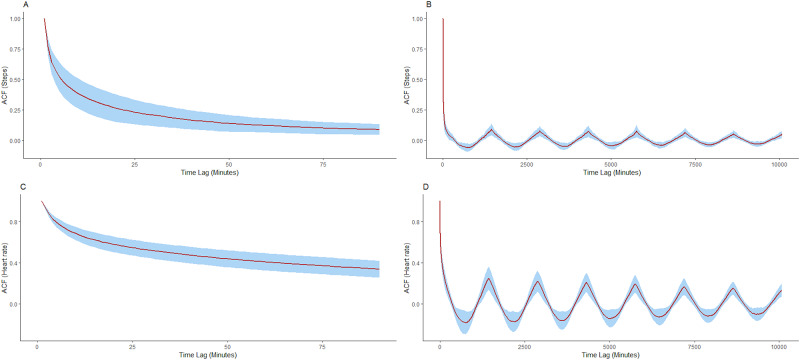
Autocorrelation (ACF) values for steps with time lags of 90 minutes (A), 10,080 minutes (B) and heart rate with time lags of 90 minutes (C) and 10,080 minutes (D).Average ACF values are shown in red and the blue ribbon represents ± 1 standard deviation.